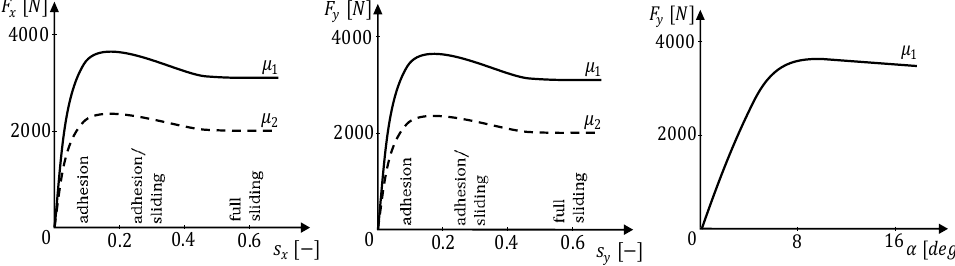
Figure 8. Non-linear characteristics of the dependence of tangential reactions on tire slip ratio and sideslip angle.